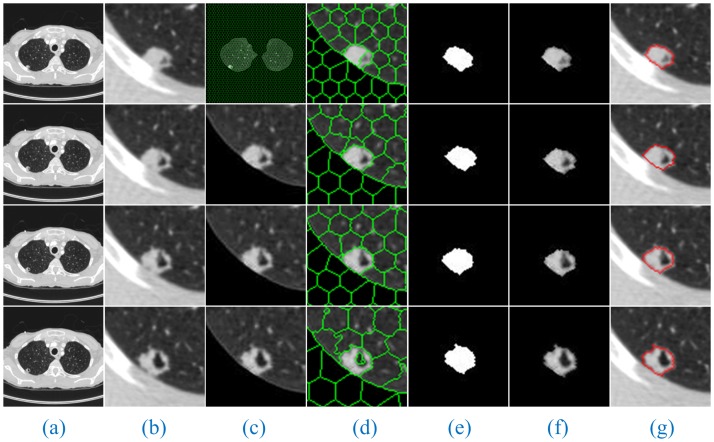
The sequence segmentation results of our method for cavitary nodules.The detailed descriptions are the same as in Fig 5.